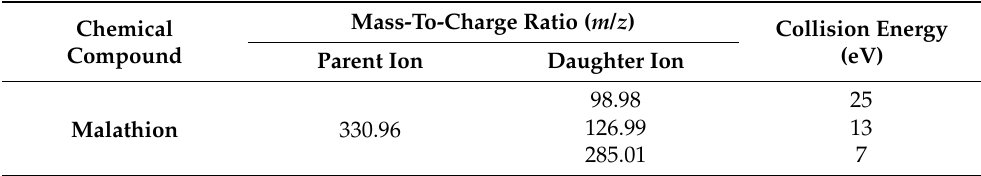
Table 1. Parameters of the mass spectrometry MRM detection mode. Chemical